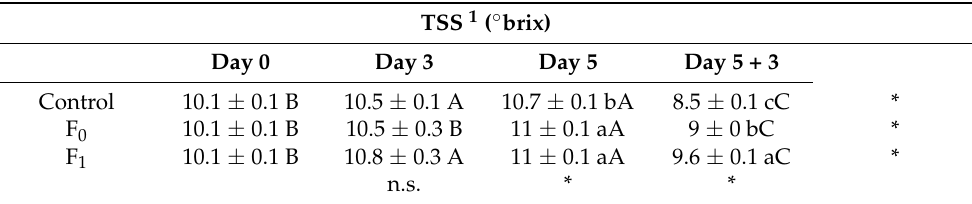
Table 7. R.S.R. per treatments/each analysis date.